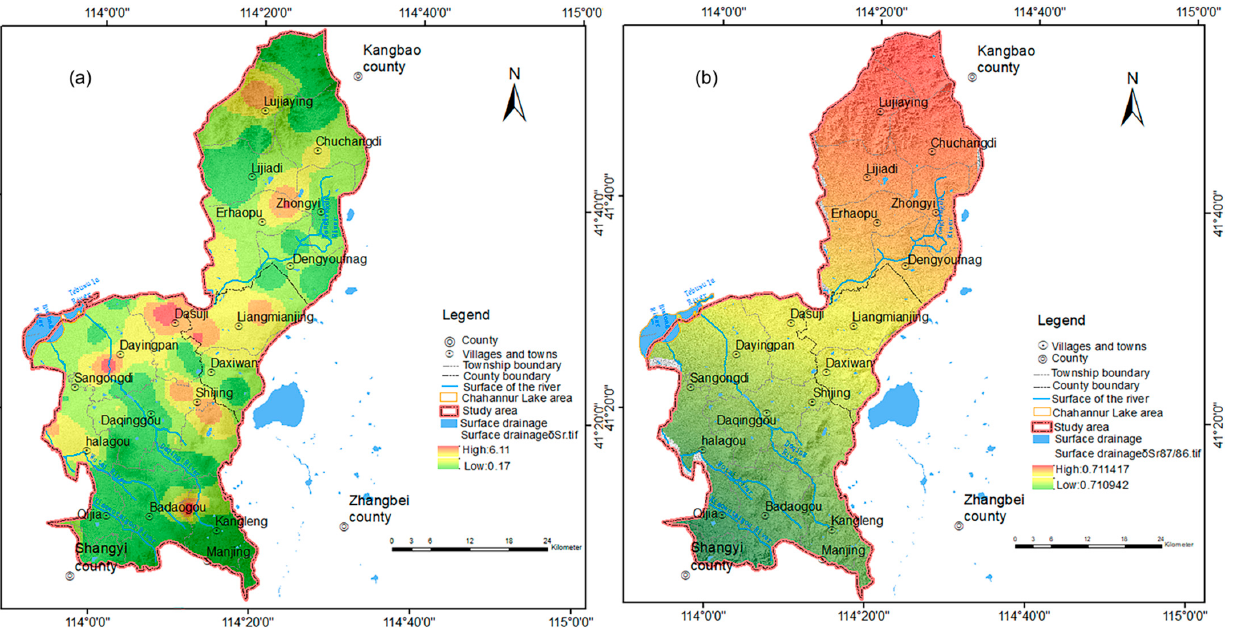
Figure 8. ( a ) Spatial distribution characteristics of Sr 2+ content and ( b ) spatial distribution of ground- water 87 Sr/ 86 Sr ratio.